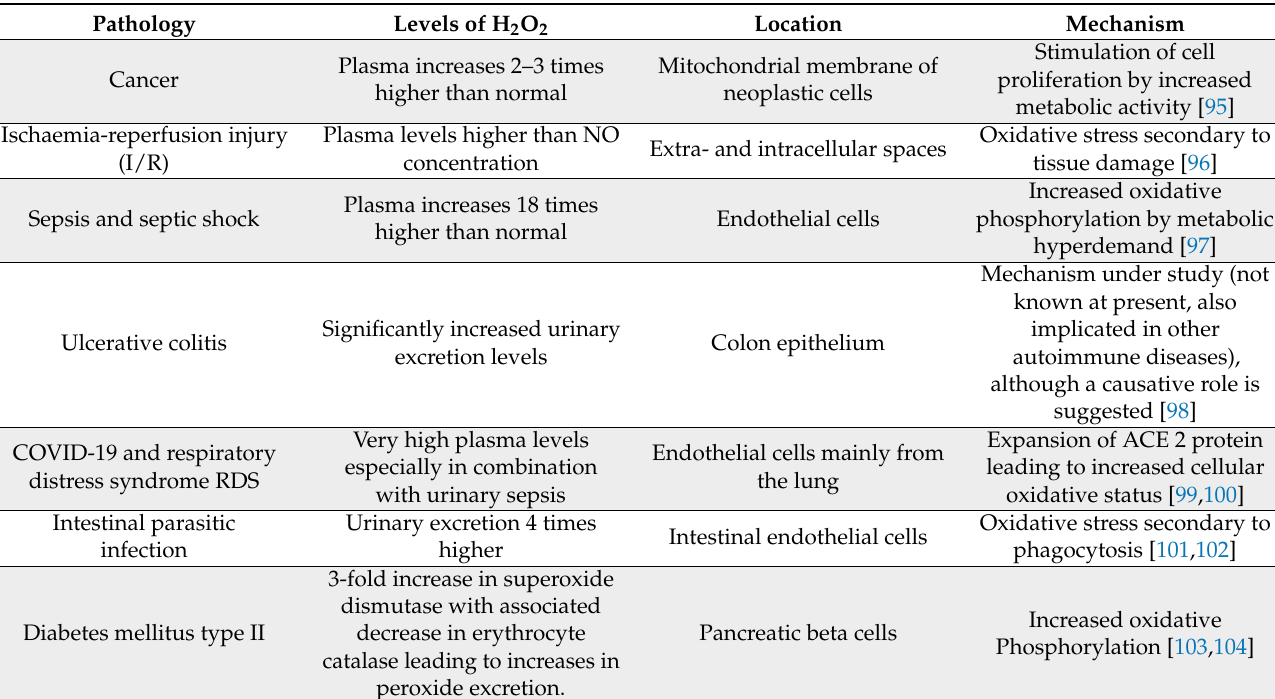
Table 1. Relationship between H 2 O 2 and